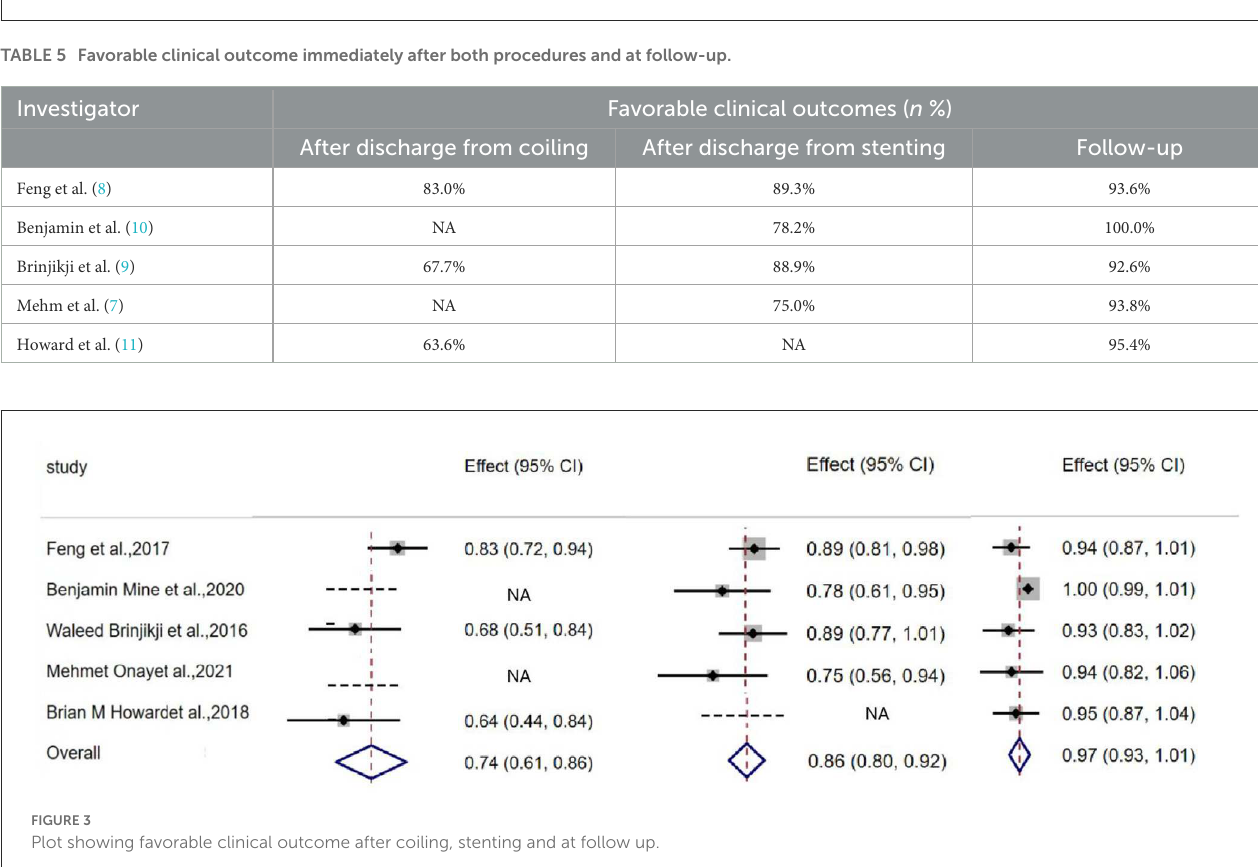
FIGURE2 Plot showing complete occlusion rate after coiling, stenting and at follow up.